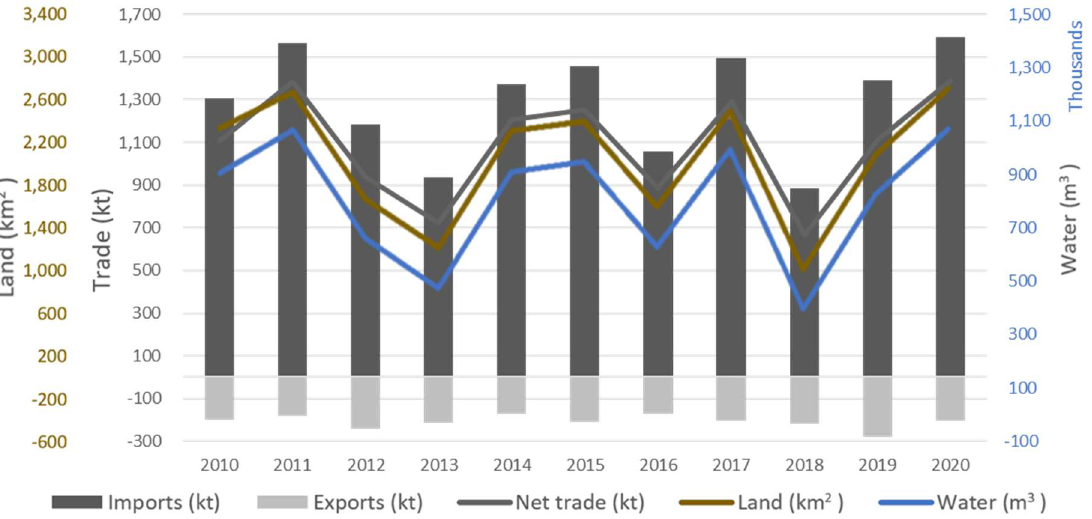
Figure 15. Sri Lankan imports, exports, and net flow in terms of quantities, virtual water, and virtual land from 2010 to 2020.